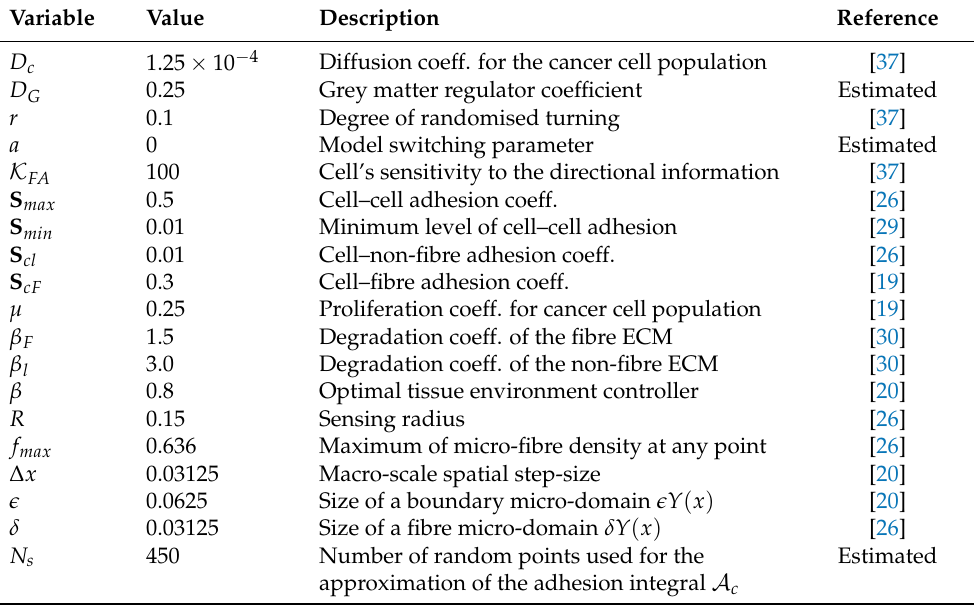
Table A1. Parameter set used for the numerical